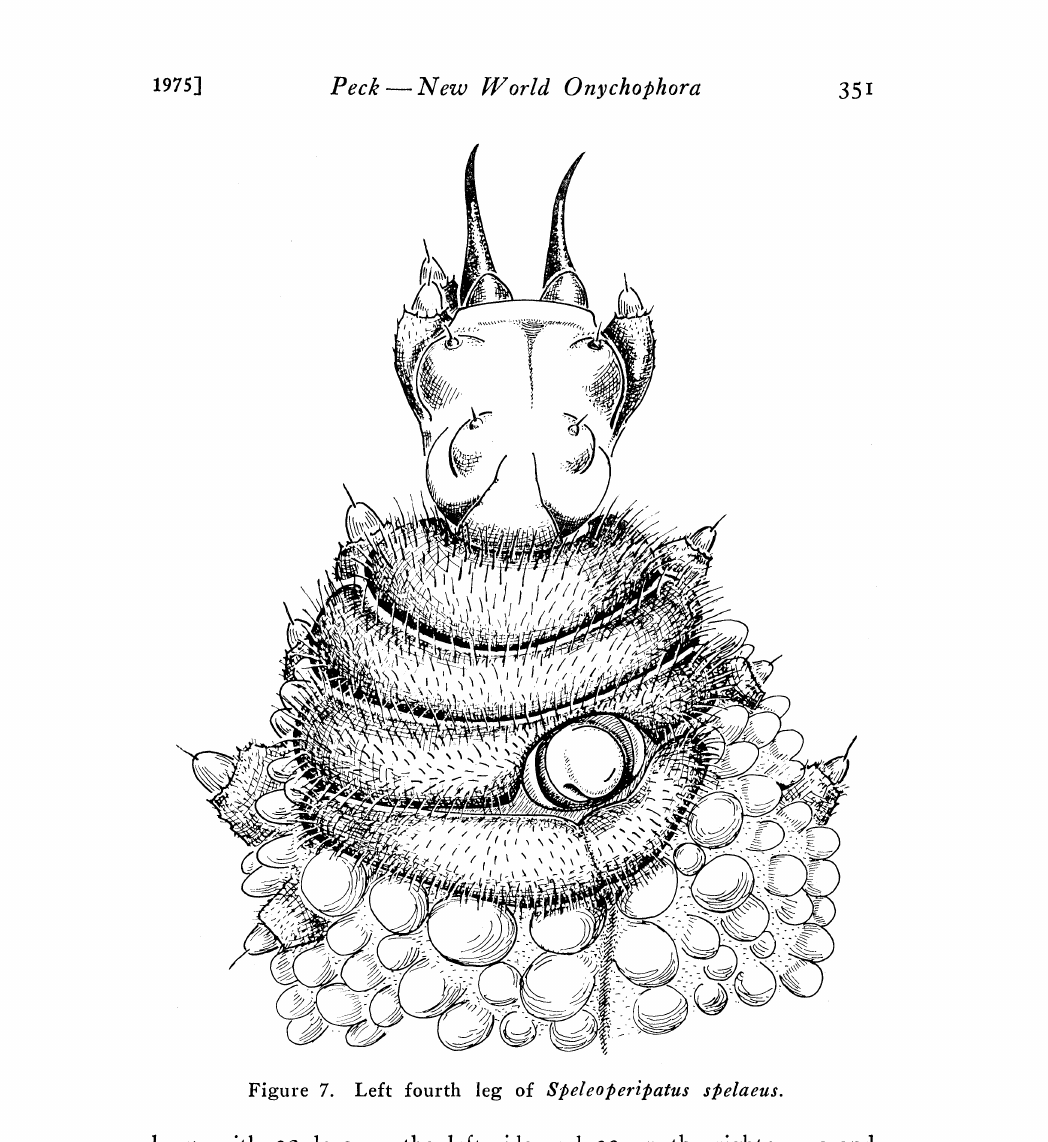
Figure 7. Left fourth leg of Seleoleritatus stelaeus. long, with 23 legs on the left side and 22 on the right; a second 34 mm long with 22 pairs o.f legs, and the third 34 mm long with 23 pairs of legs. Widths 2 to 3 mm depending on